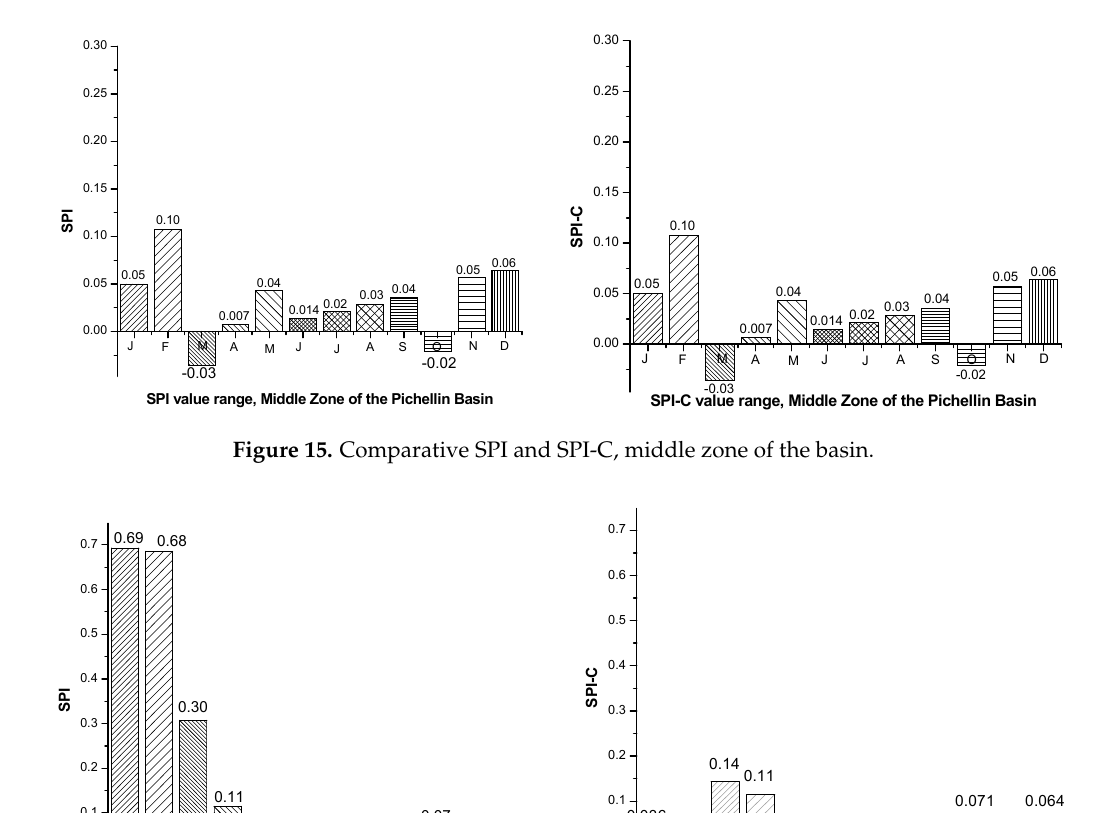
Figure 14. Comparative SPI and SPI-C, high zone of the basin.